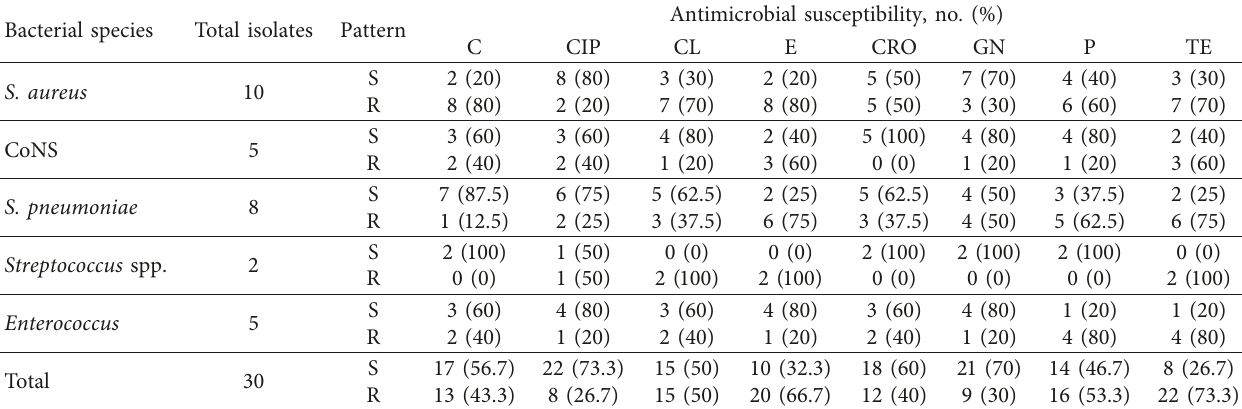
Antimicrobial susceptibility, no .